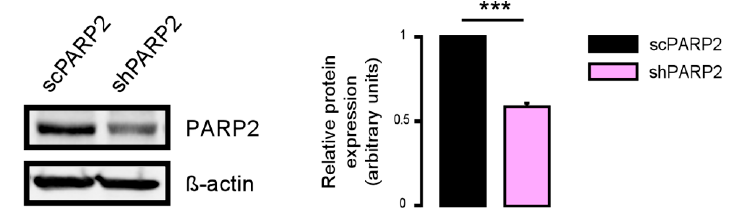
Figure 1. Validation of PARP2 silencing in stably-transfected C2C12 cells. PARP2 expression was assessed in scPARP2 and shPARP2 cells by Western blotting ( n = 3). *** represents statistically significant differences between the scPARP2 and shPARP2 cells at p < 0.001.